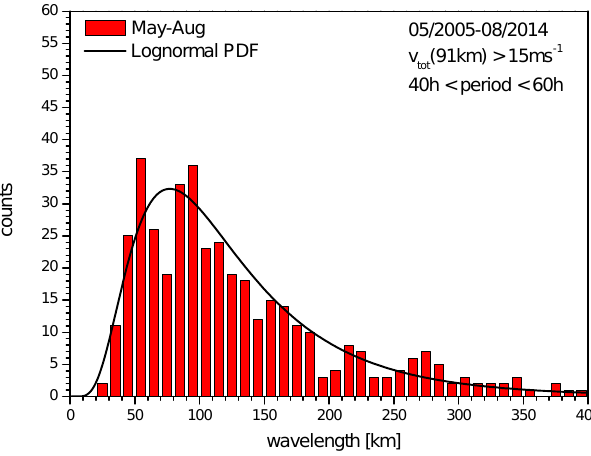
Figure 8. Histogram of daily vertical wavelengths during summer (May–August) for the time period from 2005 to 2014 (red bars) where only dates with total amplitude > 15ms − 1 are used. Wave- lengths longer than 400km are not shown (this refers to 56 days out of 460). A fitted lognormal probability density function in